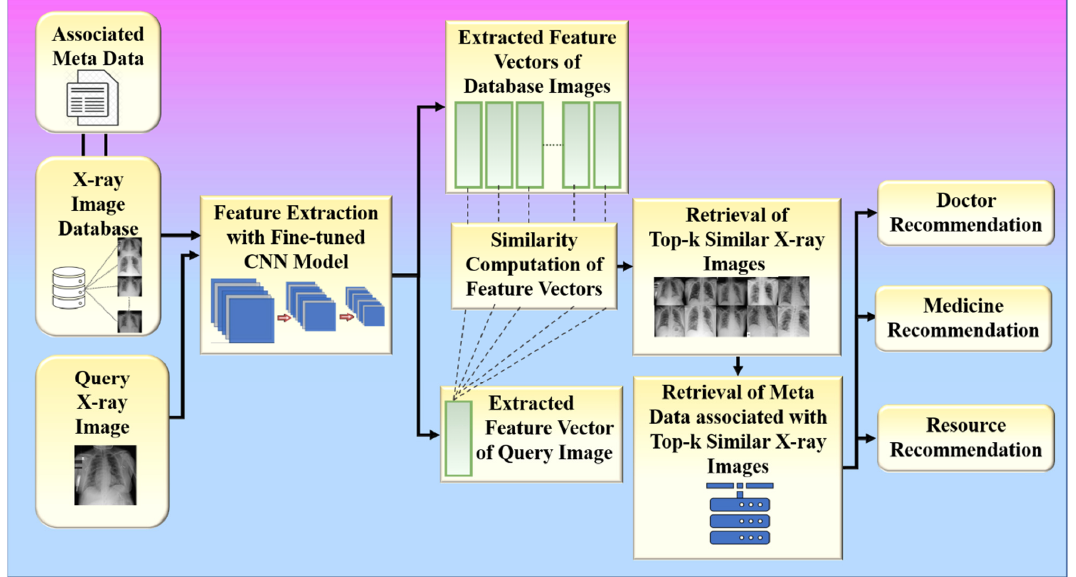
Figure 10. The data flow of the proposed system.